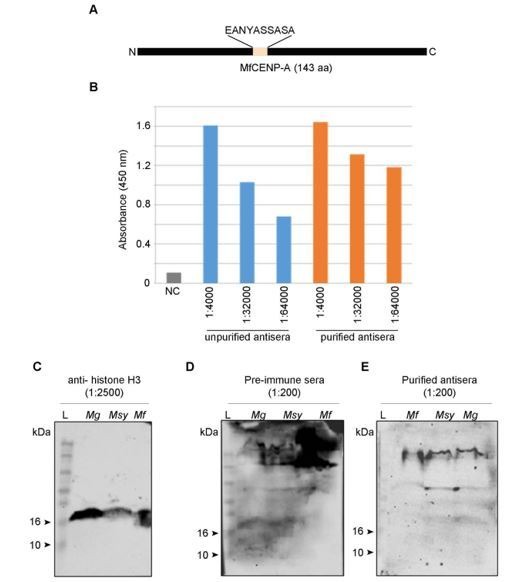
Figure corresponding to the generation of antibodies against CENP-A in Malassezia species.(A) A line diagram of MfCENP-A indicating the peptide sequence (EANYASSASA) at positions 75-84 aa used for generation of antibodies in rabbit. (B) Detection of the peptide epitope by antibodies before and after purification by ELISA. For this assay, 50 ng peptide was coated in each well and probed with varying dilutions of the antisera (1:4000, 1:32000, 1:64000). Absorbance at 450 nm was recorded after the addition of stopping solution and absorbance values are plotted for each sample in the y-axis. NC- no antigen control, (C–E) whole cell extracts from M. globosa (Mg, CBS7966 strain), M. sympodialis (Msy, ATCC42132 strain) and M. furfur (Mf, CBS14141 strain) were probed with pre-immune sera, purified CENP-A antisera, and histone H3 antisera in various dilutions as indicated. Lane L denotes the protein molecular weight markers. Both pre-immune sera and the purified antibodies were tested at a dilution of 1:200 while histone H3 antibodies were used at 1:2500 dilution.